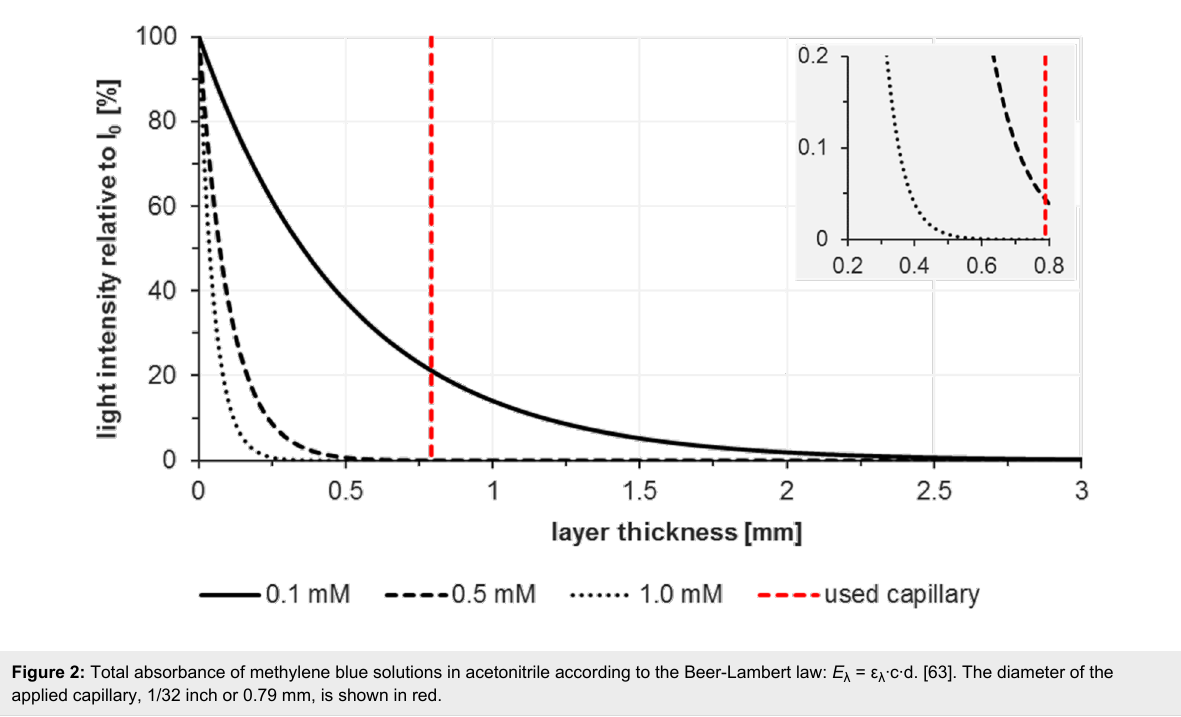
Figure 2: Total absorbance of methylene blue solutions in acetonitrile according to the Beer-Lambert law: E λ = ε λ ·c·d. [63]. The diameter of the applied capillary, 1/32 inch or 0.79 mm, is shown in red.